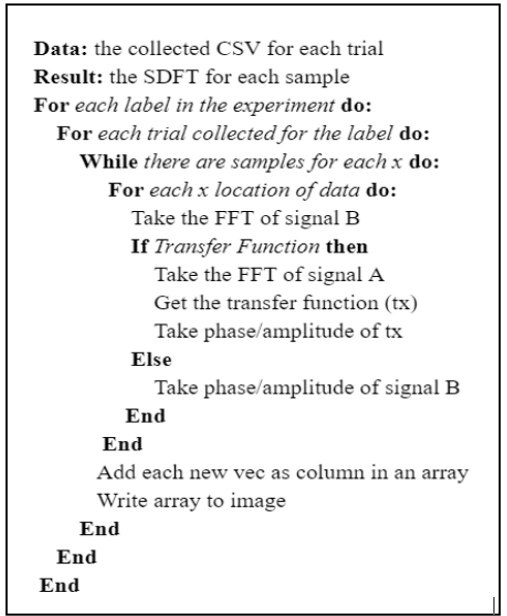
Figure 8. Pseudocode describing the process of creating SDFTs for CNN